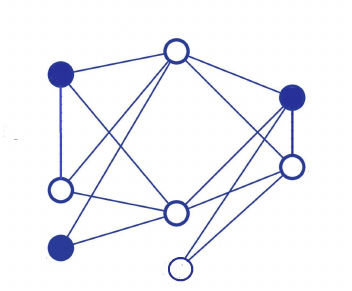
Figure 5. The network with eight nodes, and 14 links.